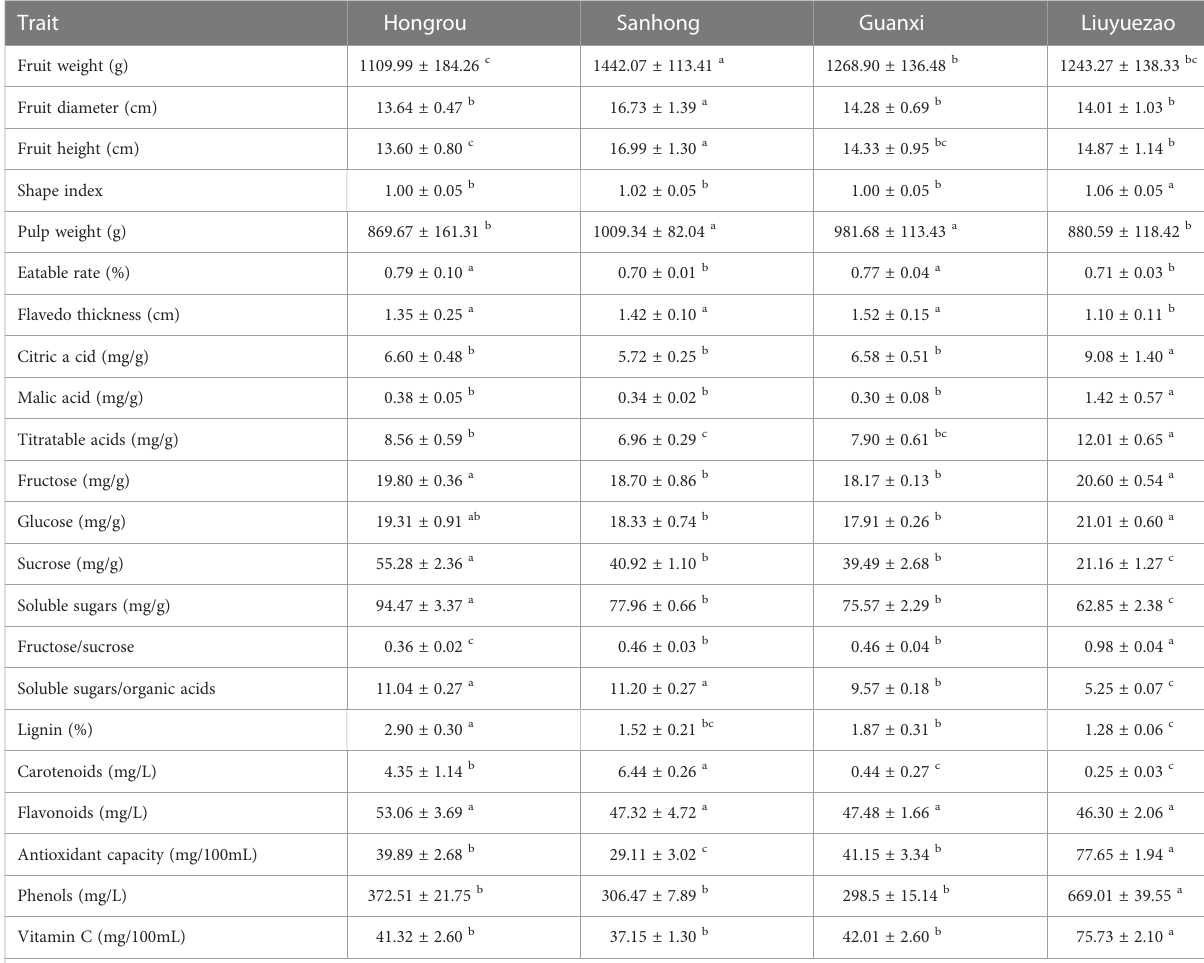
TABLE 1 Fruit quality traits of the four pummelo cultivars.